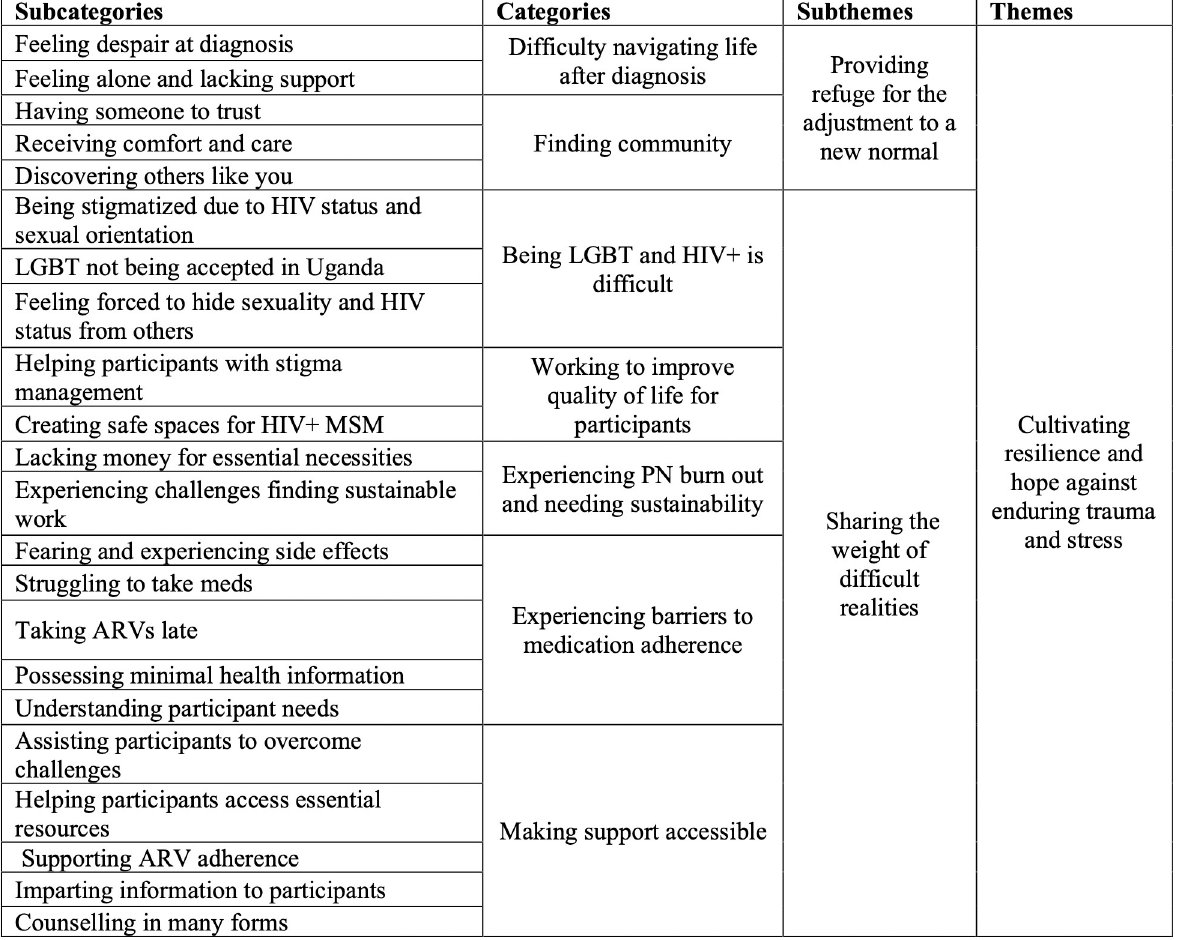
Fig 1. Analytical model of subcategories, categories, subthemes, and